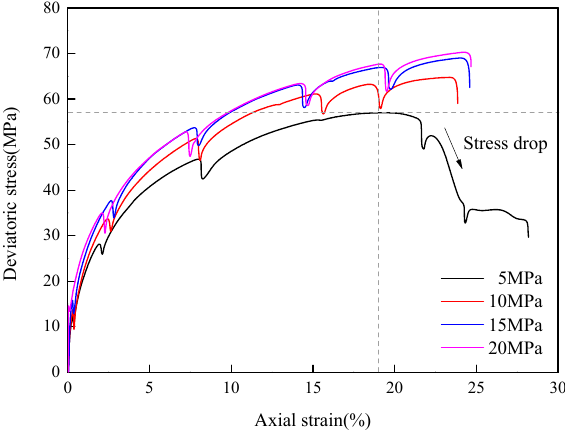
Figure 5. Stress–strain curves of salt rock under different confining pressures.